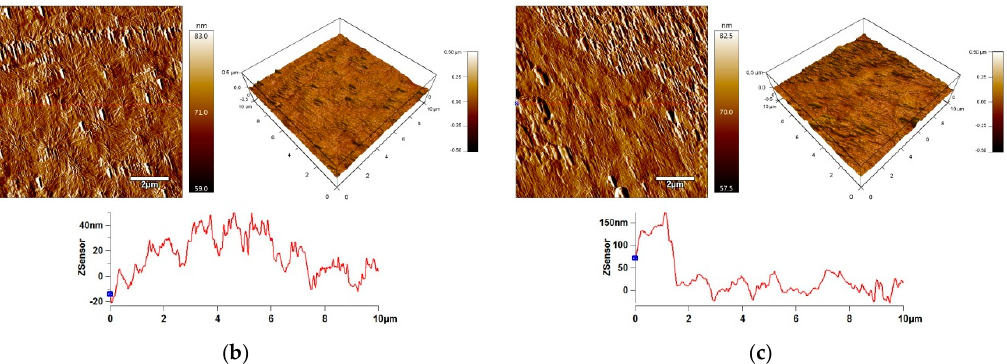
Figure 25. AFM height images of plasma treated LDPE (120 s) in gas mixtures with 1:1 ratio: ( a ) nitrogen/oxygen ( R a = 15.8 nm); ( b ) argon/oxygen ( R a = 18.0 nm); ( c ) nitrogen/argon ( R a = 21.5 nm).